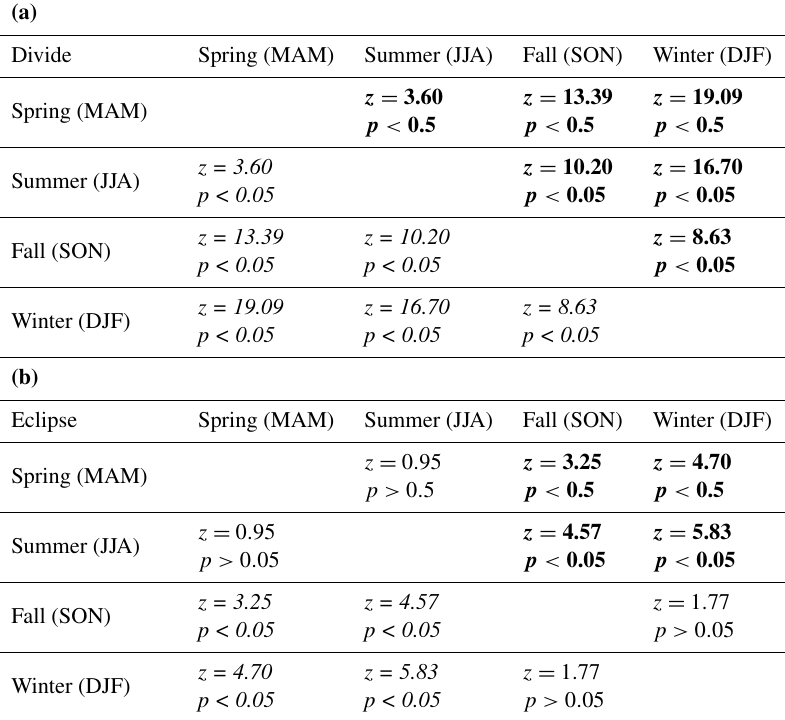
Table 4. Results for Wilcoxon rank sum tests between seasonal MODIS brightness temperature offsets from AWS temperatures at (a) Divide and (b) Eclipse. Brightness temperatures for bands 31 and 32 are averaged together. Bolded cells indicate a more pronounced cold offset in the column season; italicized cells indicate a more pronounced cold offset in the row season; and standard-font cells indicate no significant difference between the